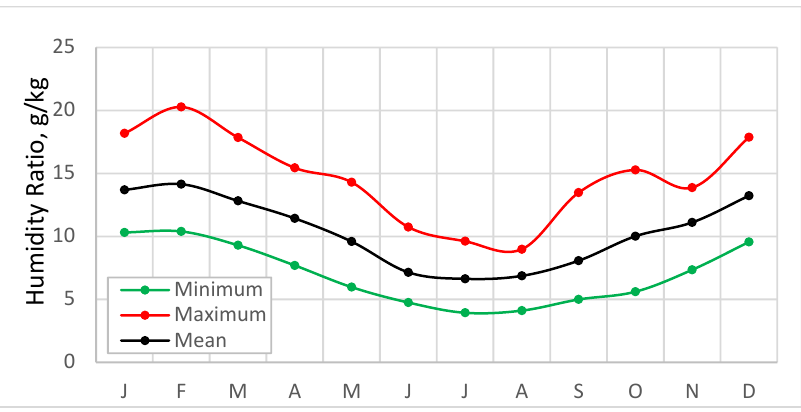
Figure 5. Monthly humidity ratio profiles.